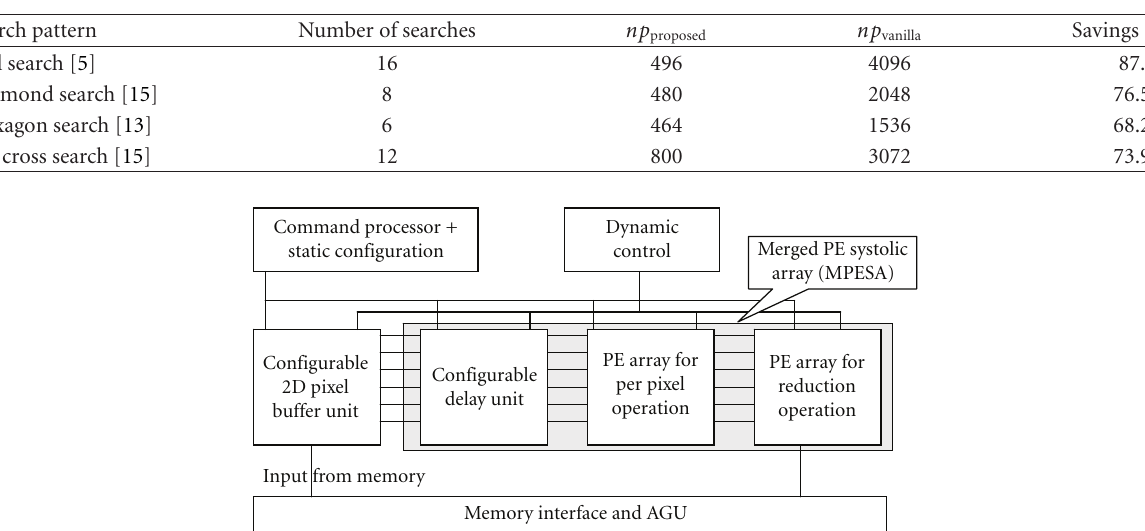
Table 1: Savings obtained (in terms of pixels fetched) by exploiting data reuse.